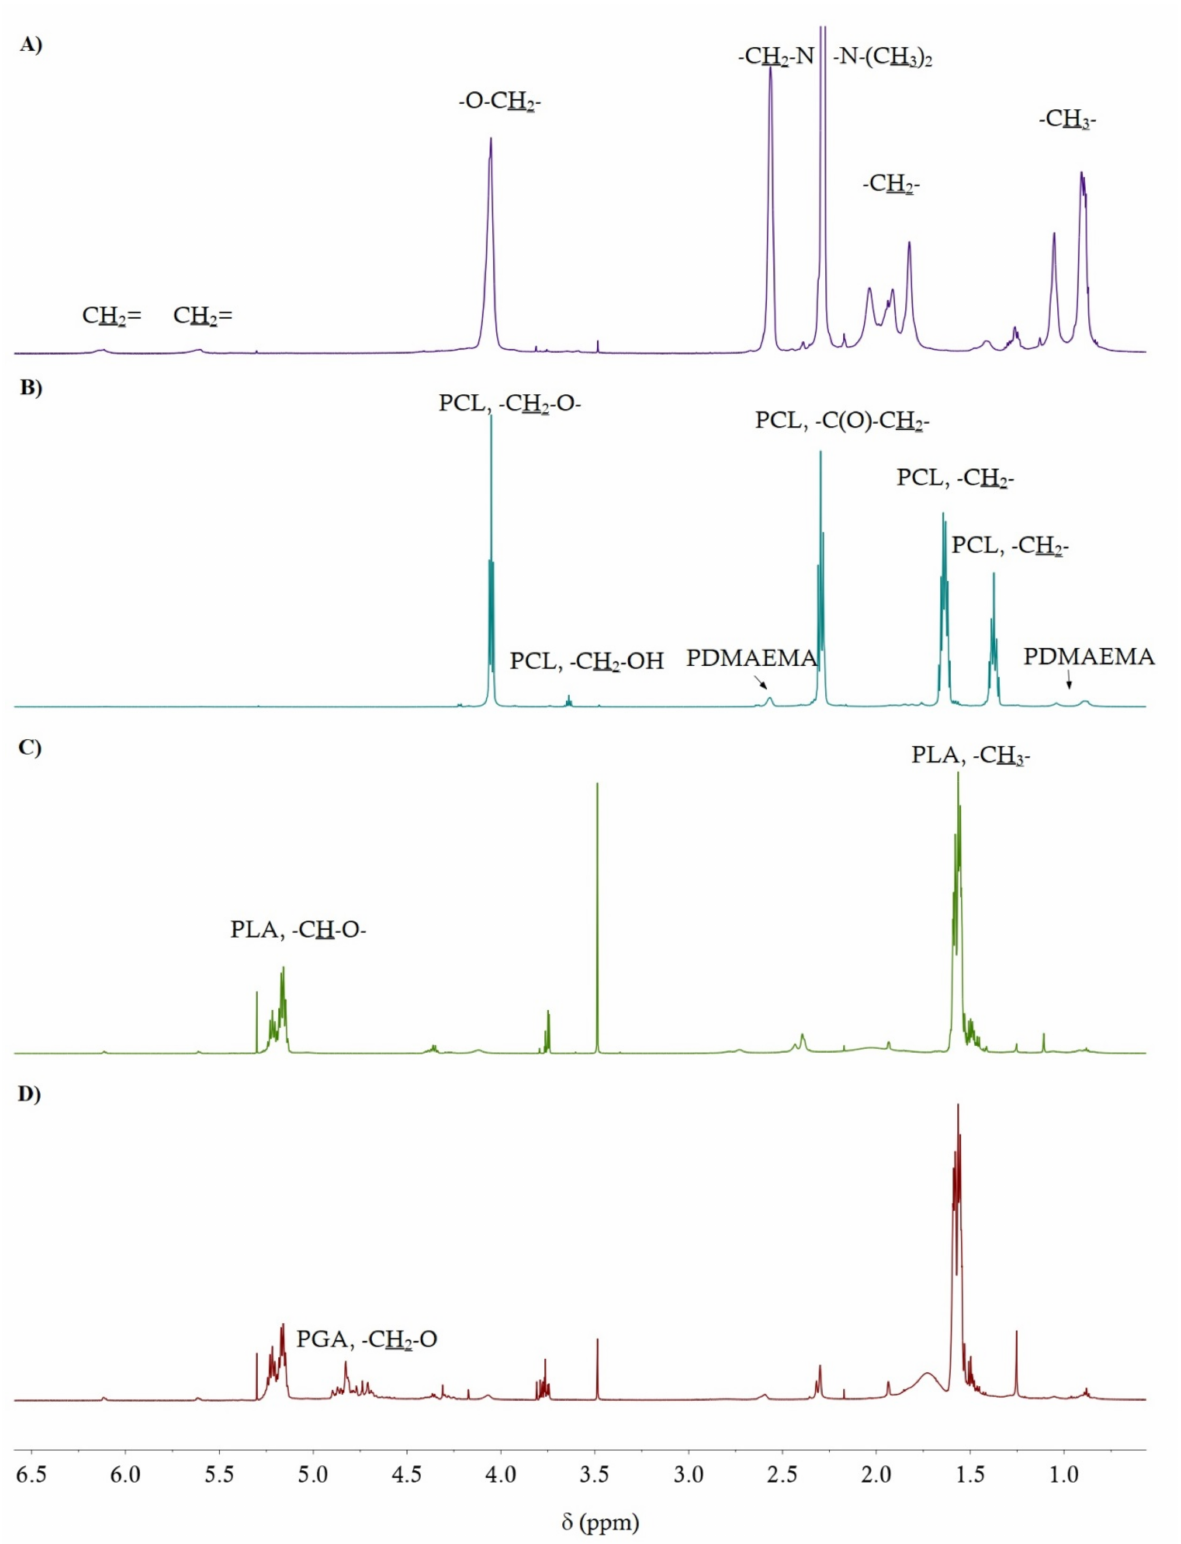
Figure 2. 1 H NMR (600 MHz, CDCl 3 ) spectra of MI ( A ) and MP1 ( B ), MP2 ( C ) and MP3 ( D ) miktopolymers before